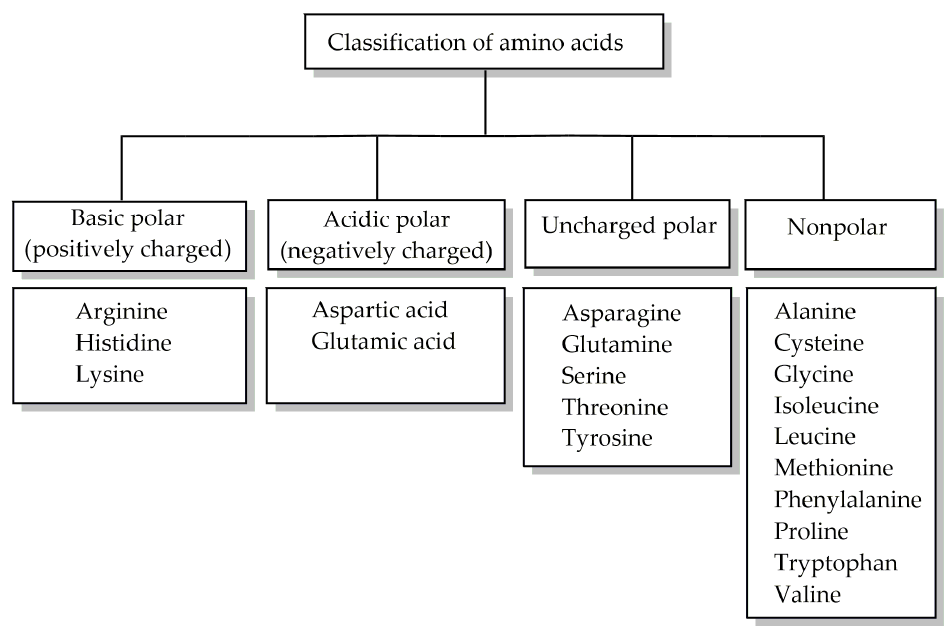
Figure 5. Classification of 20 basic amino acids based on polarity.